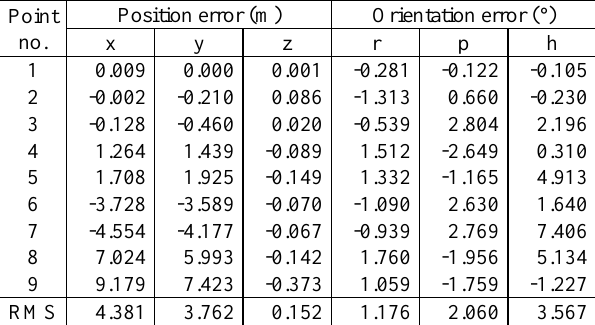
Table 2. Pure inertial navigation: position and orientation errors of check-points relative to the reference boundaries According to Table 2, the RMS position errors in both x and y exceeded few meters; and that in z reached decimetre-level. The